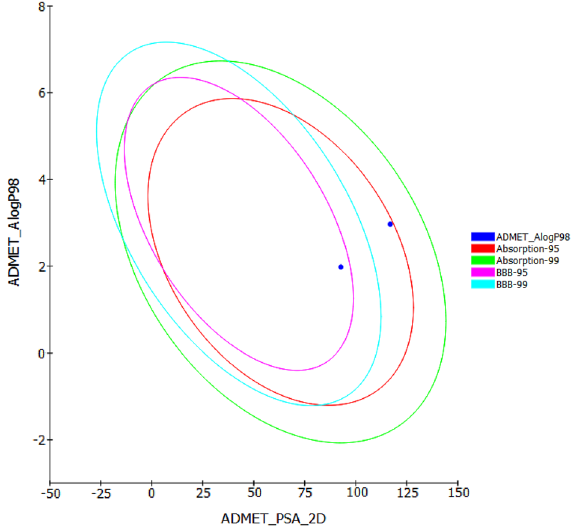
Figure 14. ADME plot of the ( IIIf ) and ( VIb ). (Dassault Systèmes. (2016). BIOVIA Discovery Studio Studio was used to generate this figure, https:// disco ver. 3ds. com 45 .